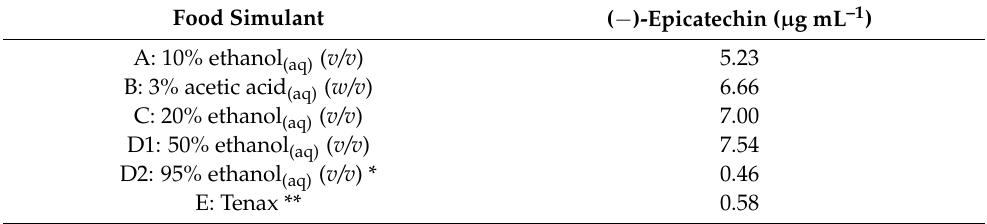
Table 2. ( − )-Epicatechin ( µ g mL –1 ) quantified in food simulants upon contact with JKRB biofoil. ( − )-Epicatechin was not detected in food simulants upon contact with the chitosan (blank) biofoil. Stock solutions of all liquid food simulants were directly analyzed, while 95% ethanol (aq) ( v/v ) was 3-fold concentrated *, and Tenax extract was 10-fold concentrated **. Food Simulant